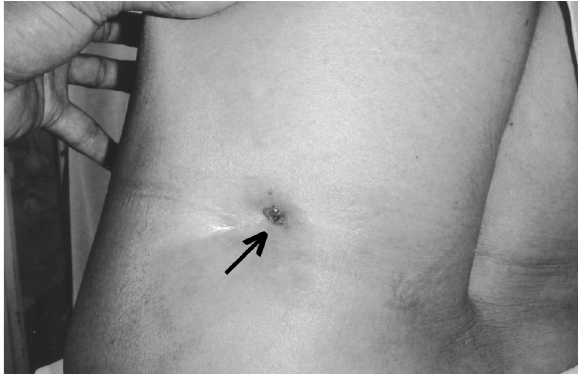
Figure 1 – Fistulous orifice in skin on left lumbar region